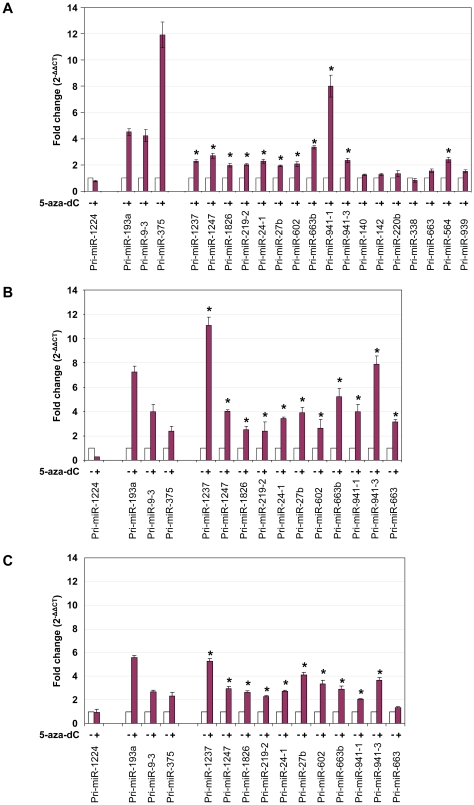
Expression analysis of candidate miRNAs after 5-aza-dC treatment.Real-time RT-PCR analysis was carried out to assess candidate primary miRNAs (Pri-miRNAs) levels in (A) HCT116, (B) RKO, and (C) DLD1 cells before and after treatment with 5 µM 5-aza-dC for 48 hr. miR-1224 was included as a negative control. miR-193a, miR-375, and miR-9-3 were included as positive controls. * indicates significant increase in Pri-miRNA expression after 5-aza-dC treatment (p<0.05). Expressions of miRNAs were internally normalized to the expression levels of GAPDH, and normalized expression for each miRNA before 5-aza-dC treatments was set to 1.